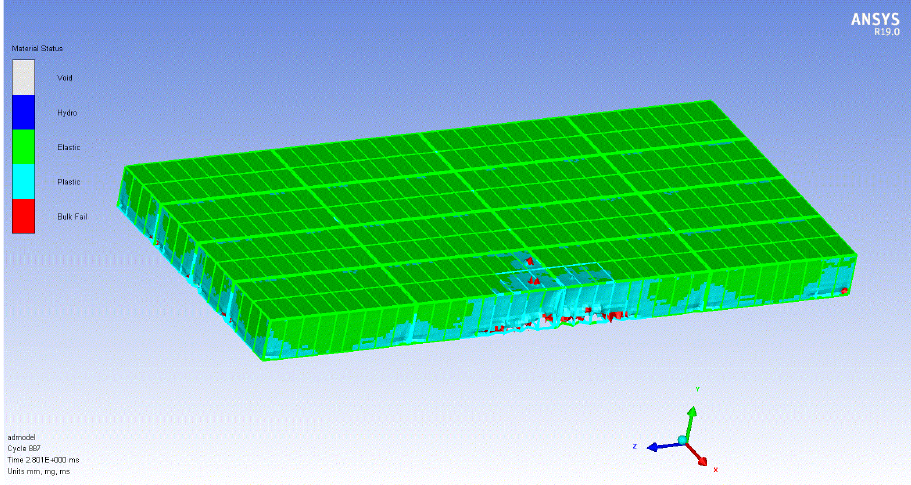
Figure 14. Material statues of the ferry.